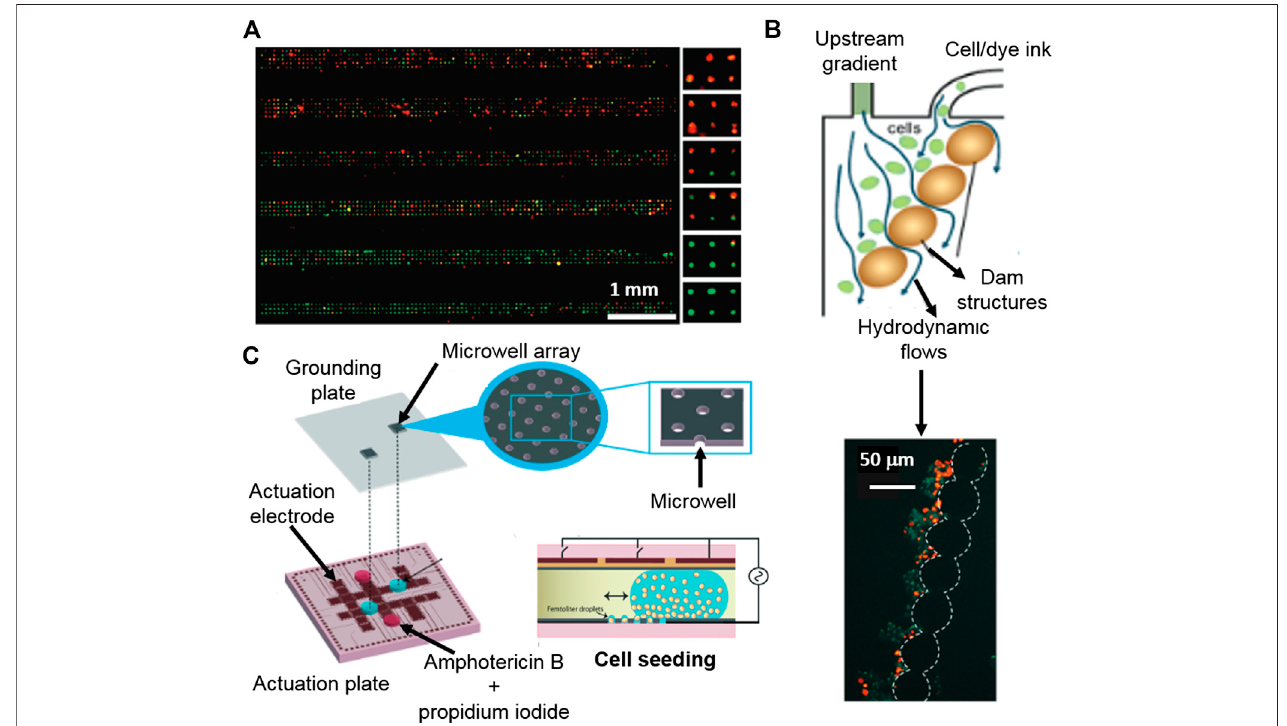
FIGURE 5 | Platforms for cytotoxicity assessment of single-cells and non-adherent cells. (A) Gradient generating micro fl uidic device based on high density single- cell arrays positioned in microcavities for HTP single-cell cytotoxicity testing. Reproduced with permission from (Hosokawa et al., 2011). Copyright © 2011 American ChemicalSociety. (B) Digitalmicro fl uidicsdeviceforsingle-celltoxicitytestingbasedtheentrapmentofsinglenon-adherentcells.Adaptedfrom(Kumaretal.,2015)with permission from The Royal Society of Chemistry. (C) Micro fl uidic platform for the cytotoxicity assessment of single-cells isolated by hydrodynamic forces using integrated, dam cell-trapping structures. Adapted with permission from (Zhao et al., 2009) Copyright © 2009 American Chemical Society.